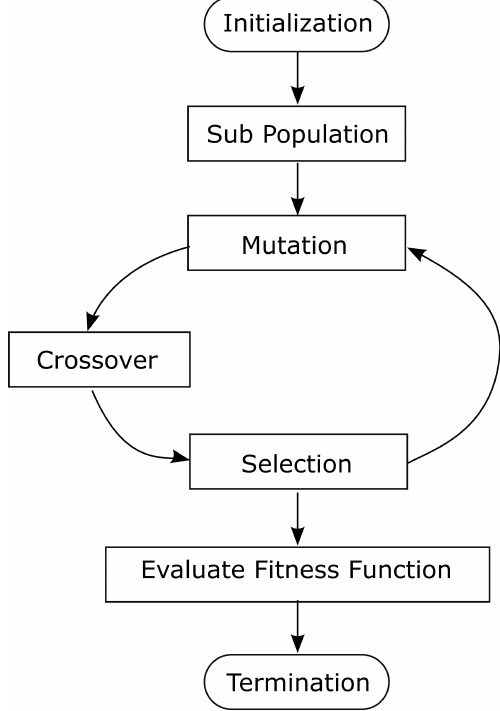
Figure 9. Differential evolution procedure.